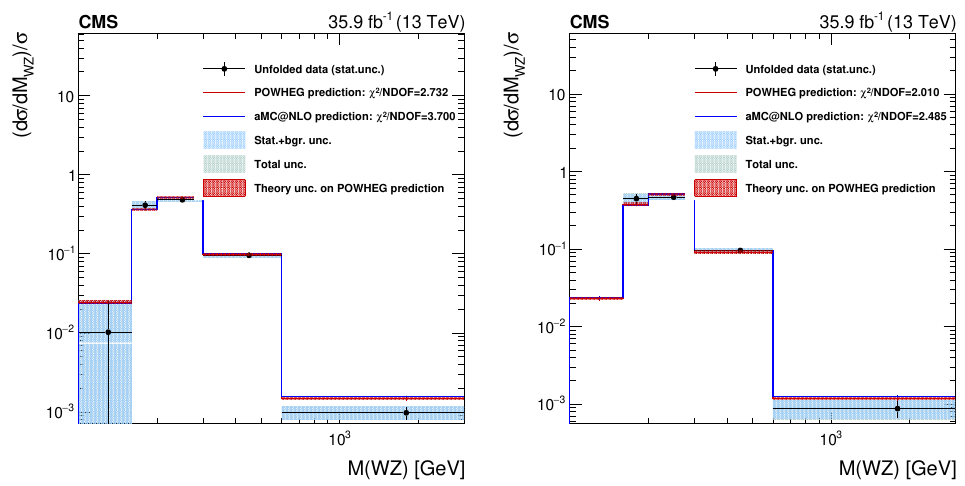
Figure 13 . Di(cid:11)erential distributions for W + (left) and W (cid:0) (right), in the full SR. The mass of the WZ system data distribution is unfolded at the dressed leptons level, as described in the text. The red band around the powheg prediction represents the theory uncertainty in it; the e(cid:11)ect on the unfolded data of this uncertainty, through the unfolding matrix, is included in the shaded bands described in the legend.